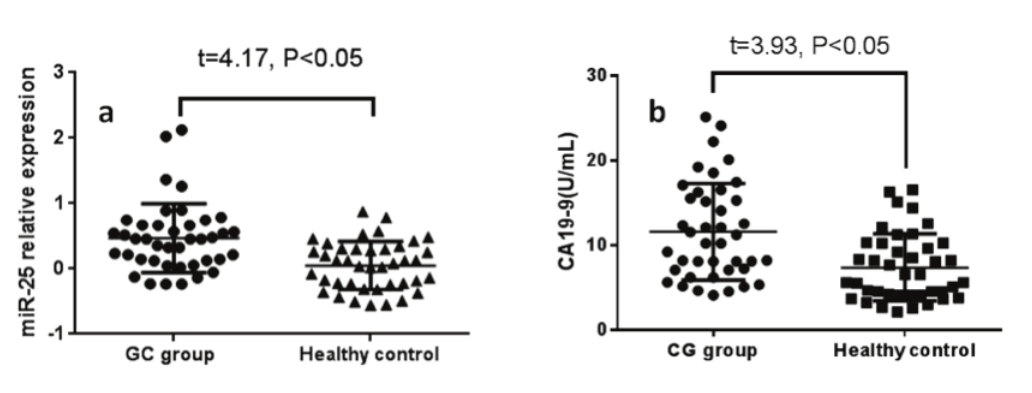
Figure 1: MiR-25 and CA19-9 expression in serum of GC patients and healthy controls (a: mirR-25 relative expression in serum of GC and healthy controls; b: CA19-9 relative expression in serum of GC and healthy